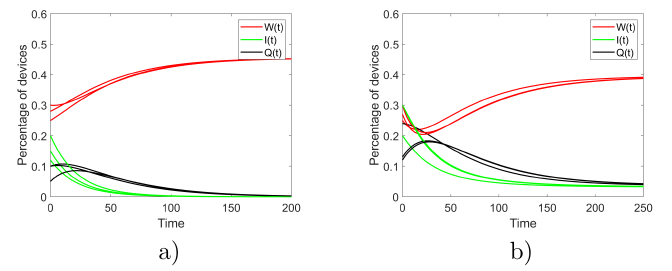
Figure 3. Time variation of system (2.2) with parameters given in (a) Example 1 and (b) Example 2 for various initial conditions.